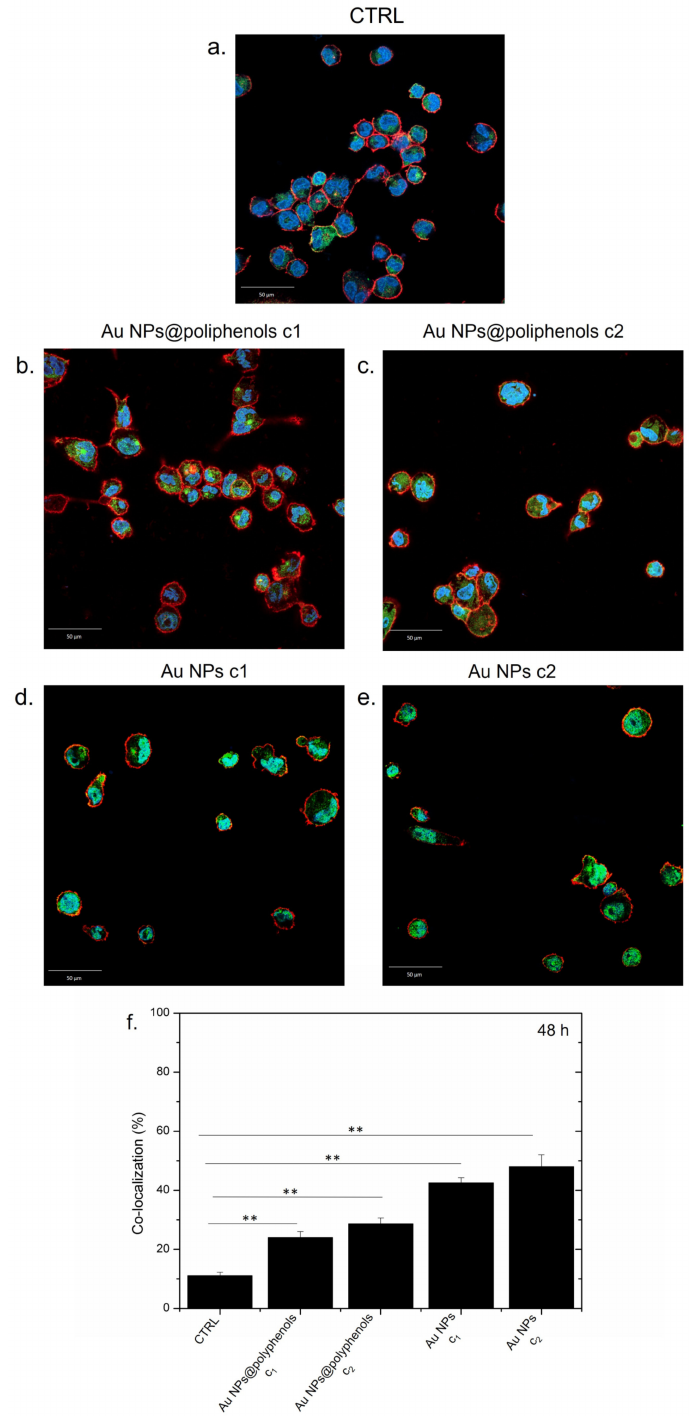
Figure 4. Representative confocal images of untreated macrophages (M0) ( a ) exposed to the c1 and c2 of Au NPs@polyphenols ( b , c ) and to the c1 and c2 of Au NPs ( d , e ) for 48 h. The cells were fixed and then labeled. The nuclei were stained with Hoechst (blue), Actin cytoskeleton with CellMask™ (red), and NF- κ B with NF- κ B p65 Antibody (F-6) FITC (green intensity signal). ( f ) Co-localization analysis of the merged fluorescence signals due to the NF- κ B translocation from the cytoplasm to the nucleus (merged blu/green fluorescence intensity signal). The data are expressed as the mean SD (5 images for n = 2) and they were considered statistically significant for a ** p <